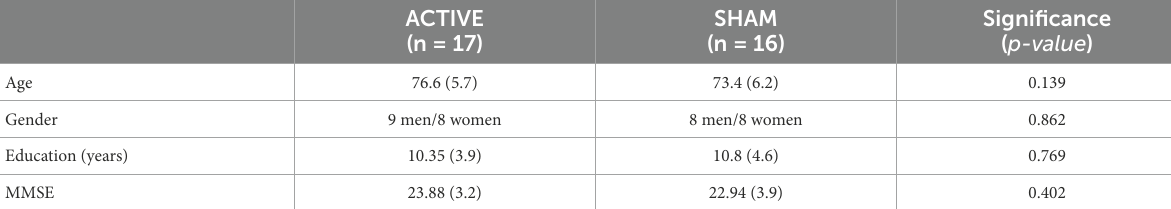
TABLE 1 Means (and SD ) of demographic indices comparing active and sham